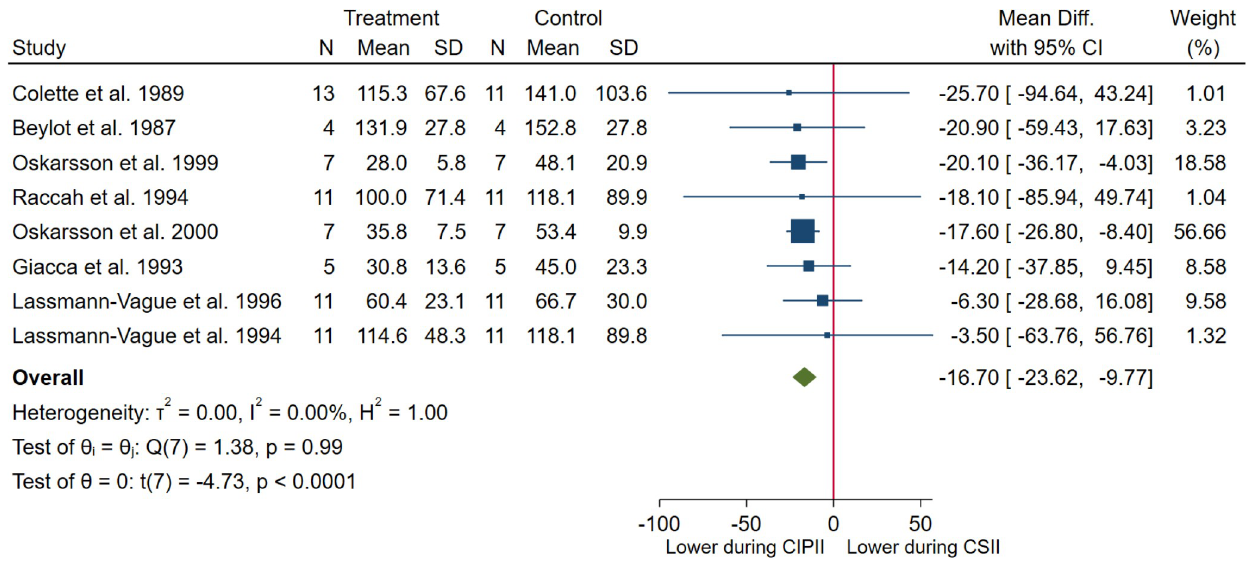
Fig 5. Meta-analysis of fasting insulin (pmol/L) in patients during CIPII treatment compared to that during control treatment (CSII). Treatment, continuous intraperitoneal insulin infusion (CIPII); Control, continuous subcutaneous insulin infusion (CSII). Studies ordered by effect size (mean